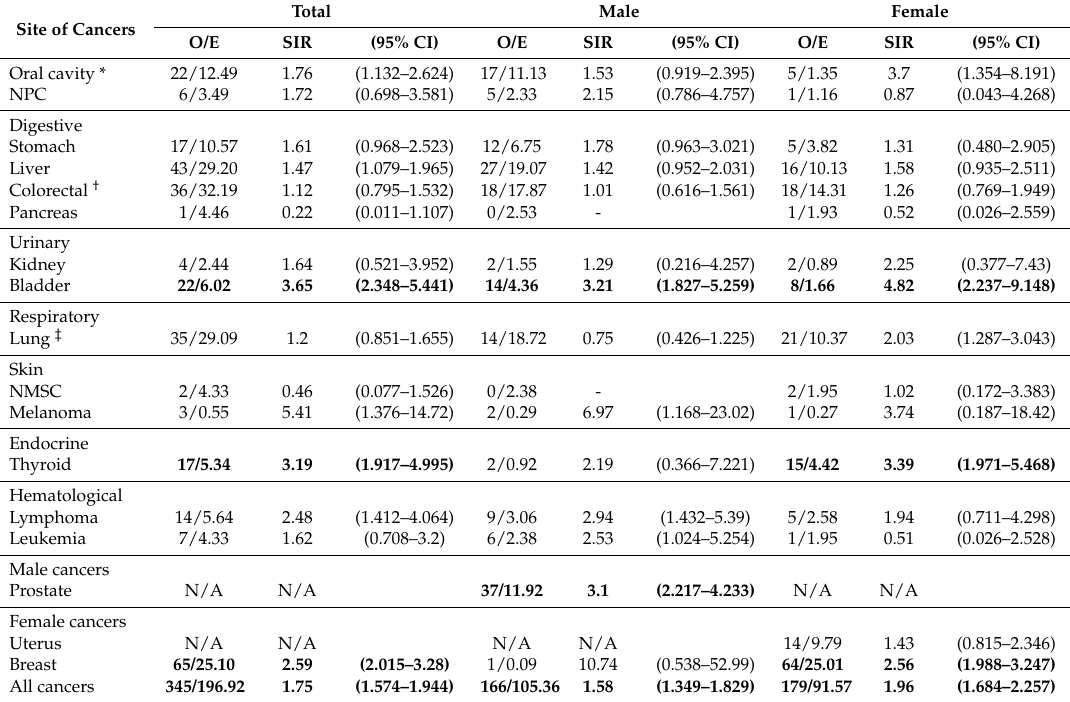
Table 3. Standardized incidence ratios for all cancers in 12,391 vitiligo